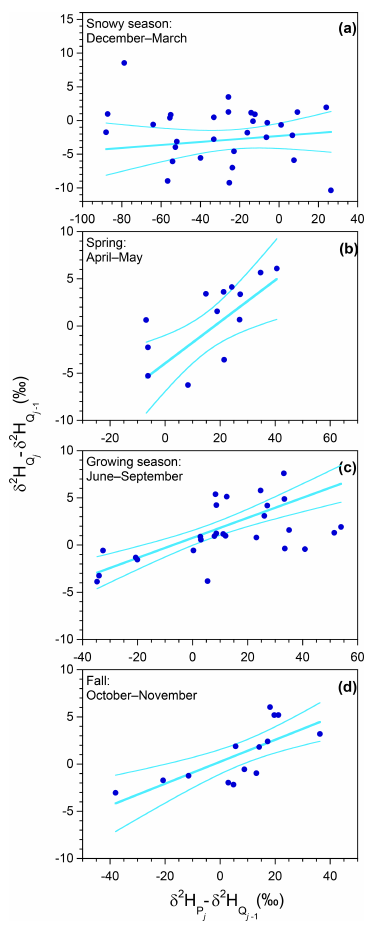
Figure 10. Ensemble hydrograph separation using biweekly iso- tope measurements at Hubbard Brook Watershed 3. Straight lines show least-squares regressions weighted by cumulative stream dis- charge over each 2-week sampling interval. Curved lines indicate 95% confidence bounds for the fits. The regression slopes yield ensemble estimates of the biweekly volume-weighted new water fraction of discharge (the volume fraction of discharge that orig- inated from precipitation that fell in the previous 2-week sam- pling interval); Q F ∗ new = 0 . 022 ± 0 . 033 during the snowy season (December–March, panel a ), 0 . 220 ± 0 . 078 during the spring (April and May, panel b ), 0 . 106 ± 0 . 028 during the growing season (June– September, panel c ), and 0 . 116 ± 0 . 034 during the fall (October and November, panel d ). Rescaling these biweekly event new water fractions by the ratio between seasonal discharge and seasonal pre- cipitation yields the biweekly volume-weighted new water fractions of precipitation (the volume fraction of precipitation that leaves as discharge within the following 2-week sampling interval); P F ∗ new = 0 . 015 ± 0 . 022 during the snowy season, 0 . 311 ± 0 . 111 during the spring, 0 . 027 ± 0 . 007 during the growing season, and 0 . 076 ± 0 . 023 during the fall. Axes vary from panel to panel, but their ratios are held constant, so the plotted lines correctly depict the relative steep- ness of the regression